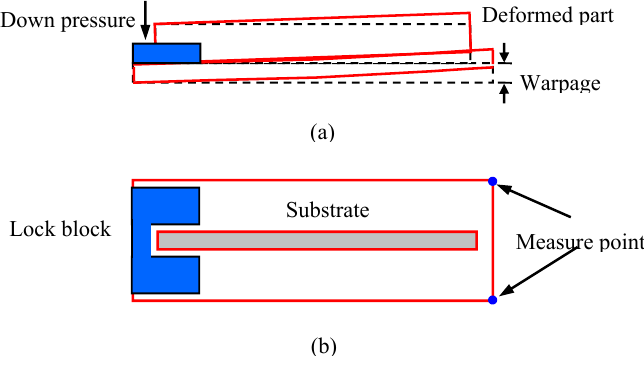
Figure 4. Schematic showing the measuring method of warpage. ( a ) side view and ( b ) top view. A fixture was designed to measure the warpage, which had a horizontal base and plane clamping structure. The manufactured part was placed flat on the base and then the lock block clamped on one end, so the other side would upwarp. The vertical displacement of the two corners was measured. The same method was used to measure the other two. The average value of the four points was used for the verification.